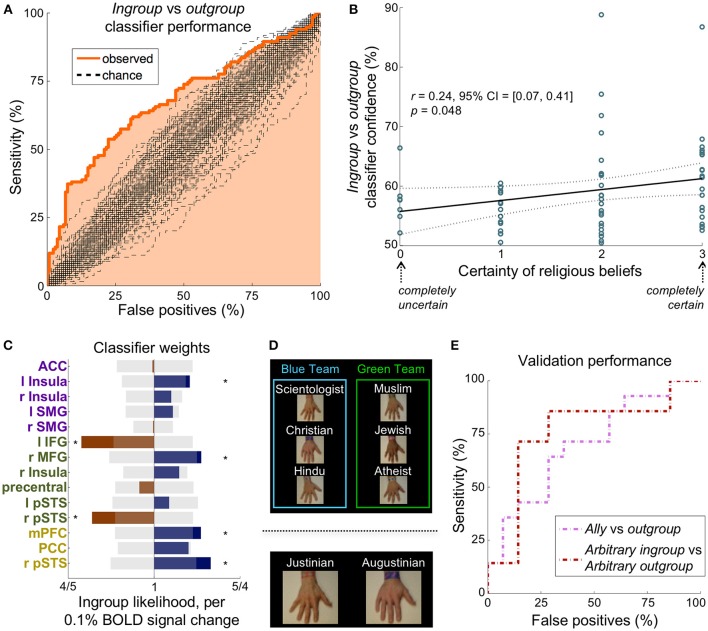
A multivariate classifier discriminates ingroup from outgroup reliably in multiple paradigms. (A) The ROC curve for distinguishing the ingroup conditions from the outgroup conditions. The AUC was 68%, which was significantly greater than the chance AUC of 50% (p < 0.01, n = 268 instances, 100 chance curves shown). (B) Participants' self-reported certainty of religious beliefs (scale from 0 to 3) correlated significantly with classifier prediction confidence, suggesting that the strength of an ingroup affiliation may be dependent on certainty. (C) The classifier feature weights in the 14 non-visual regions of the empathy (purple), relief (green), and mentalizing (yellow) networks. Translucent gray bars represent the 95% chance interval, and stars demarcate weights that contributed significantly (p < 0.05 uncorrected). (D)
Top: Experiment 2 was identical in structure to Experiment 1 except that participants were told that the hands were on two warring teams. The ally condition is an outgroup on the same team as the participant's ingroup. Bottom: Participants flipped a coin to receive an arbitrary assignment to one of two teams, Justinian or Augustinian, thus defining their arbitrary ingroup condition. (E) The ROC curves for distinguishing the ingroup condition from the outgroup condition in the two validation paradigms. The classifier determined 64 and 71% of participants' ingroup condition correctly in Experiment 2 (pink) and Experiment 3 (maroon), respectively.